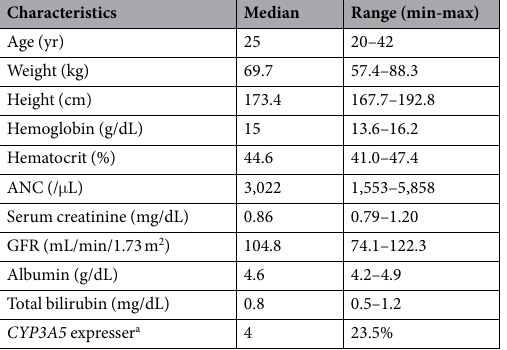
Table 1. Baseline characteristics of enrolled healthy volunteers ( n = 17). a CYP3A5 expresser is presented as number and proportion. ANC, absolute neutrophil count; CYP3A5 expresser, CYP3A5 * 1/ * 1 or CYP3A5 * 1/ * 3; GFR, glomerular filtration rate.